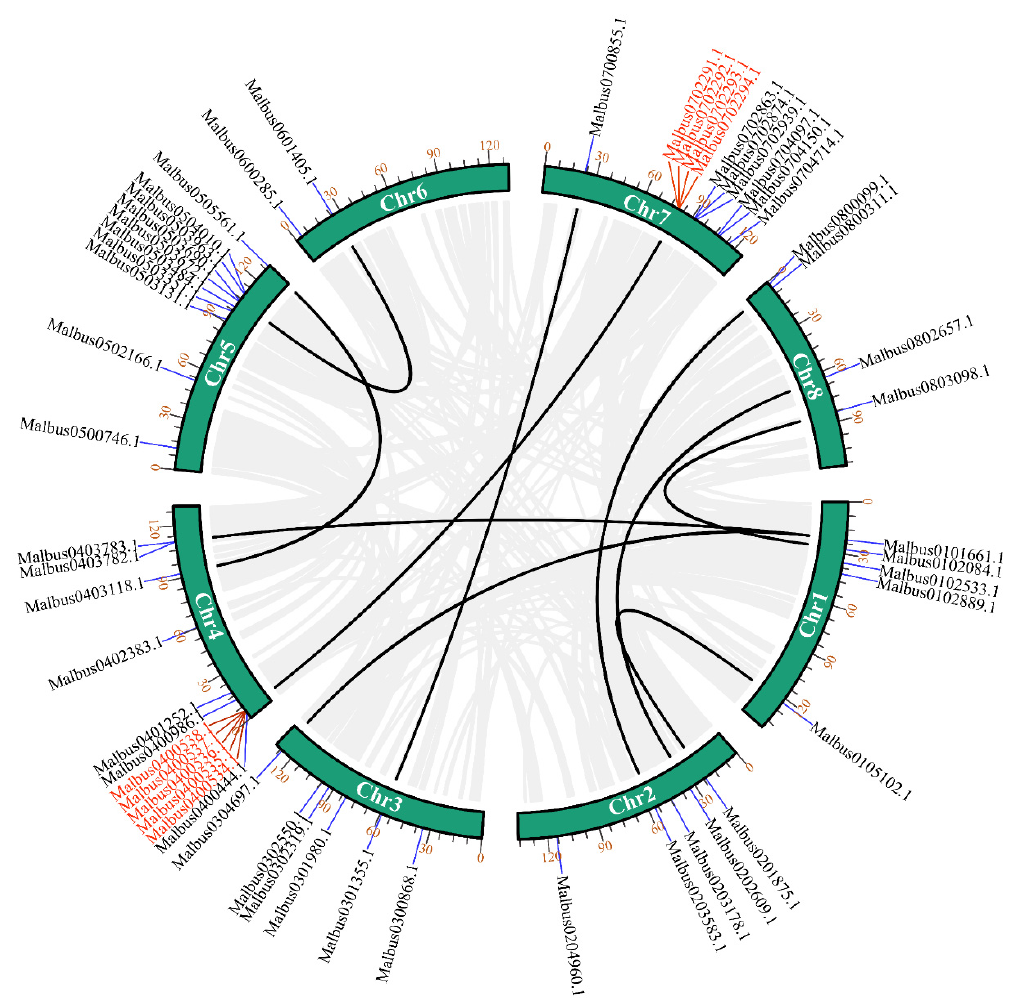
Figure 3. Distribution and synteny analysis of MaGRAS genes. In the figure, the 8 M. albus chromosomes are shown in green–colored partial circles, gene IDs are indicated at the top of each bar. Background gray lines indicate all M. albus genome synteny blocks, black lines indicate the duplicated MaGRAS genes, red lines represent the tandemly duplicated MaGRAS genes.